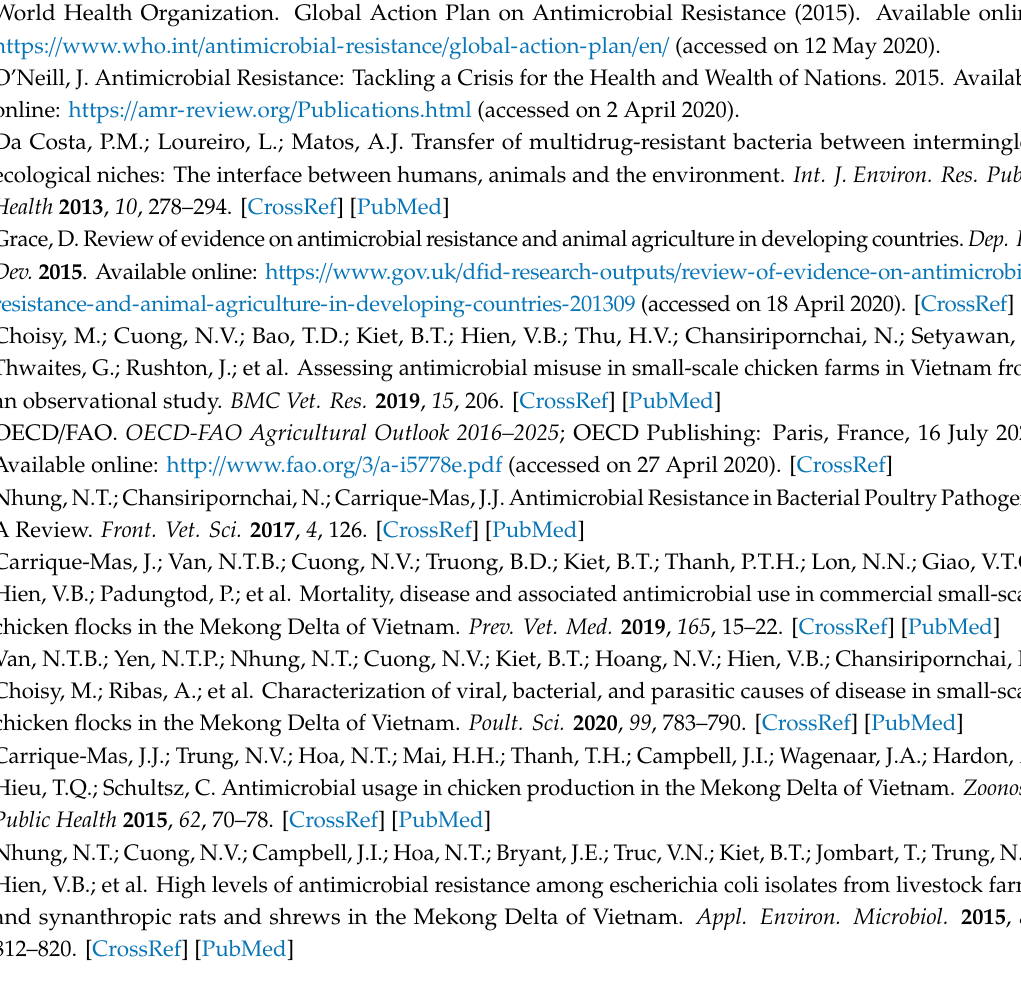
Table S1: Raw MIC data of all 58 chicken pathogens